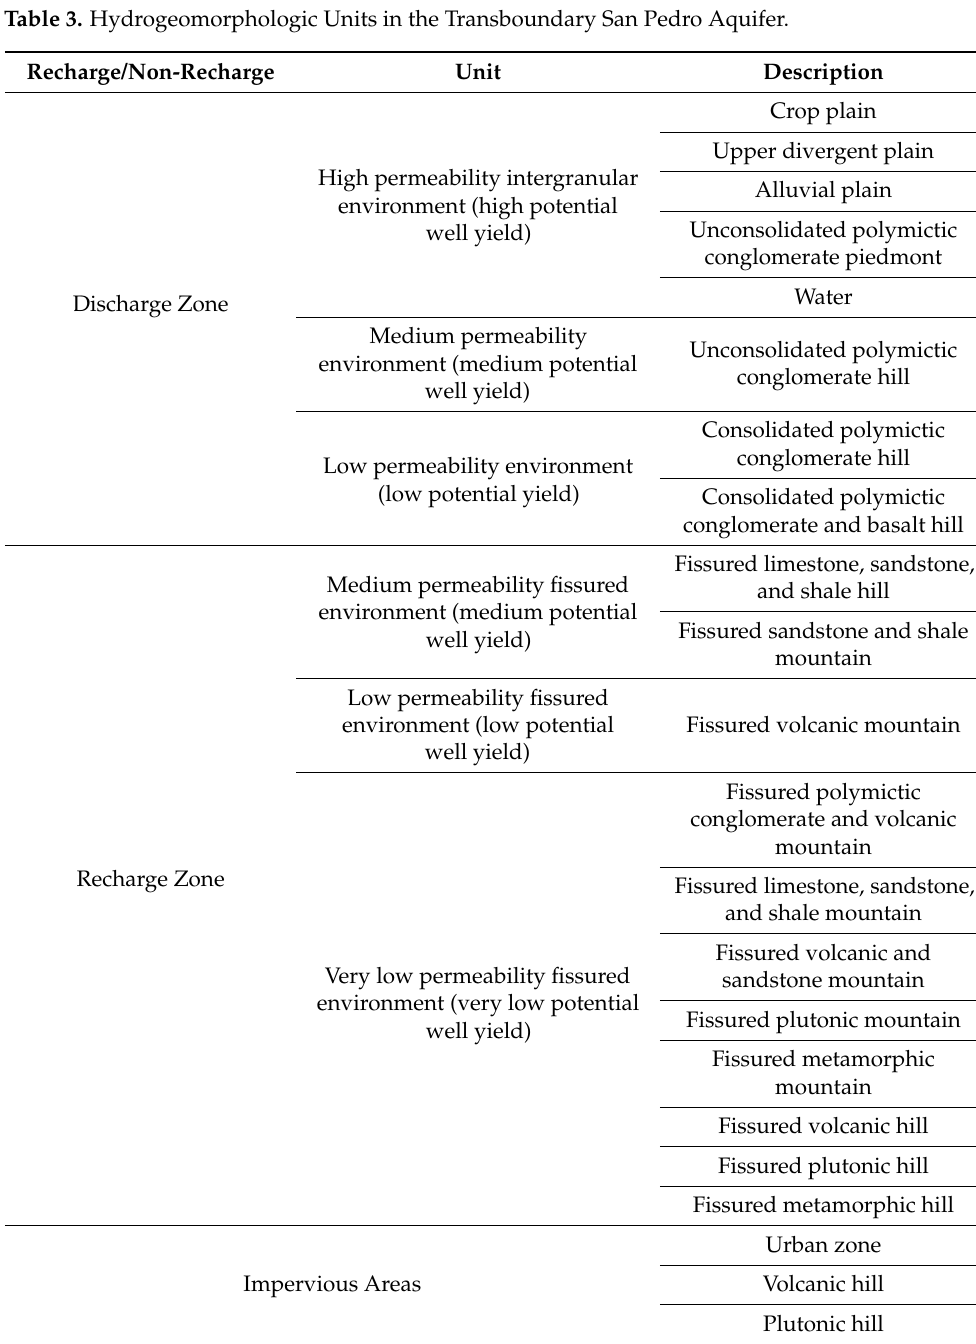
Table 3. Hydrogeomorphologic Units in the Transboundary San Pedro